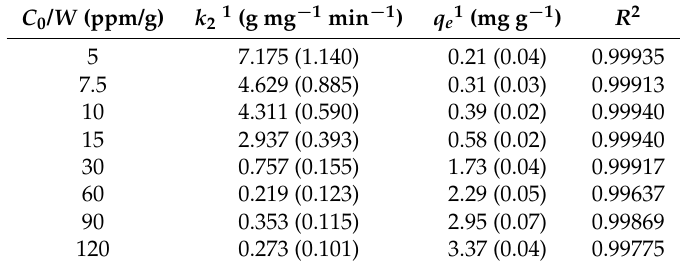
Table 1. Pseudo-second order kinetic data for experimental runs shown in Figures 5 and 6.